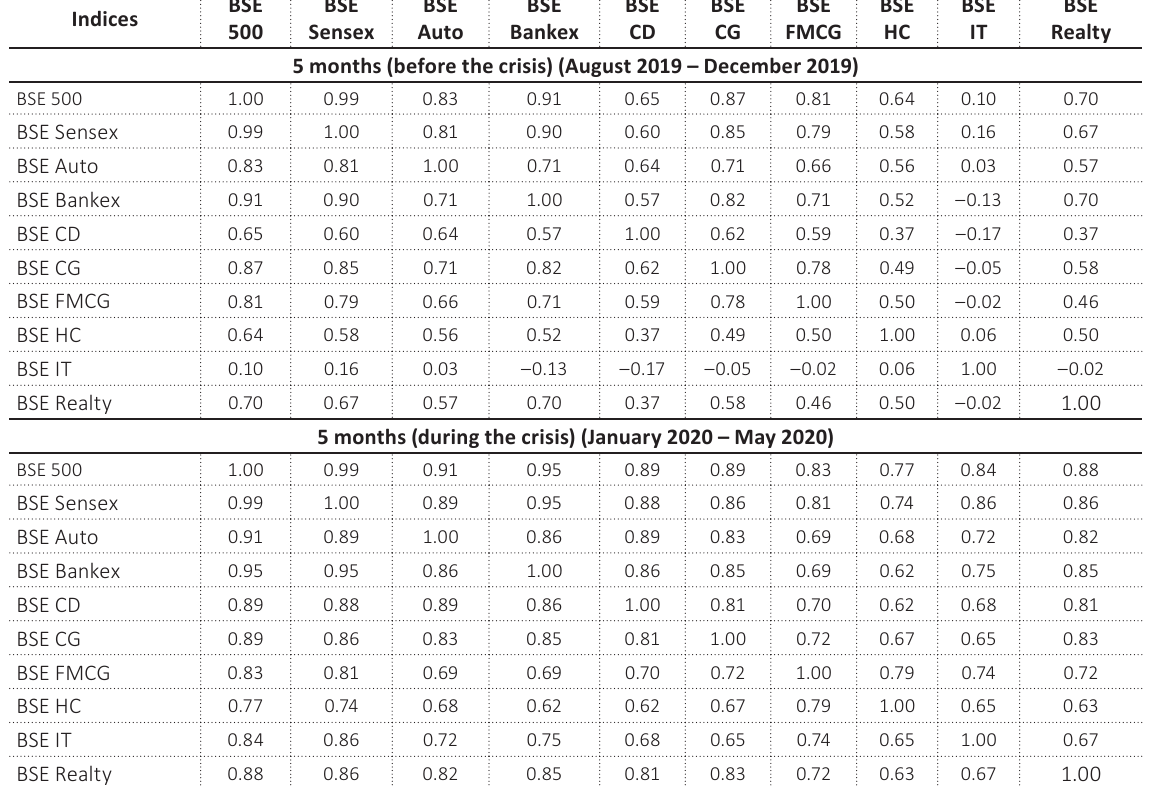
Table 3. Correlation